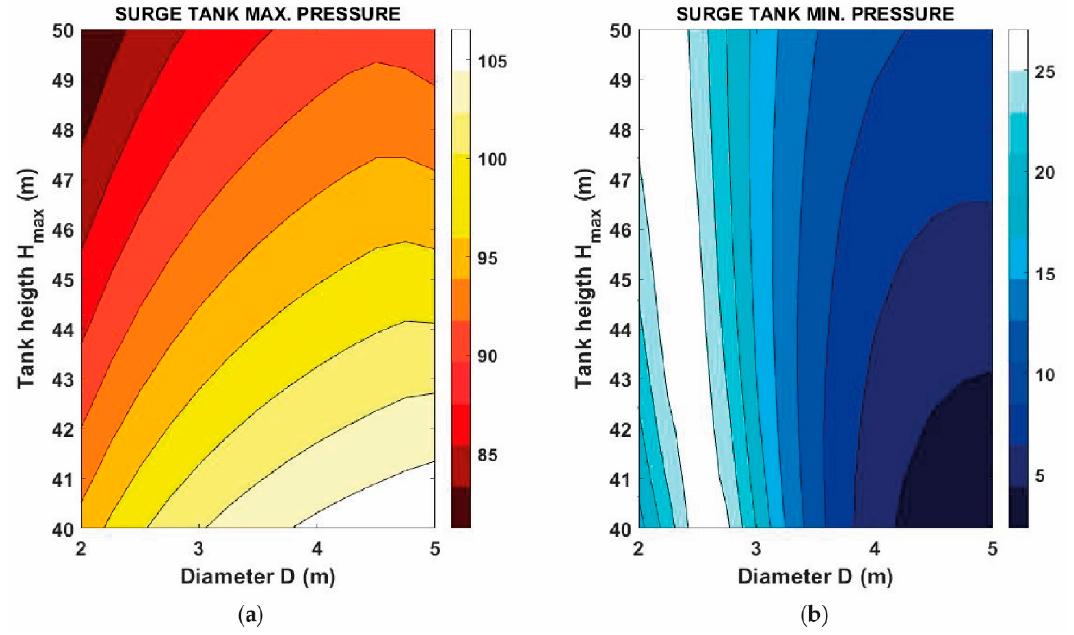
Figure 7. Transient analysis considering a closed surge tank with a diameter between 2–5 m and a height in the 40–50 m range. ( a ) Surge tank maximum air pressure (kPa); and, ( b ) Surge tank minimum air pressure (kPa).